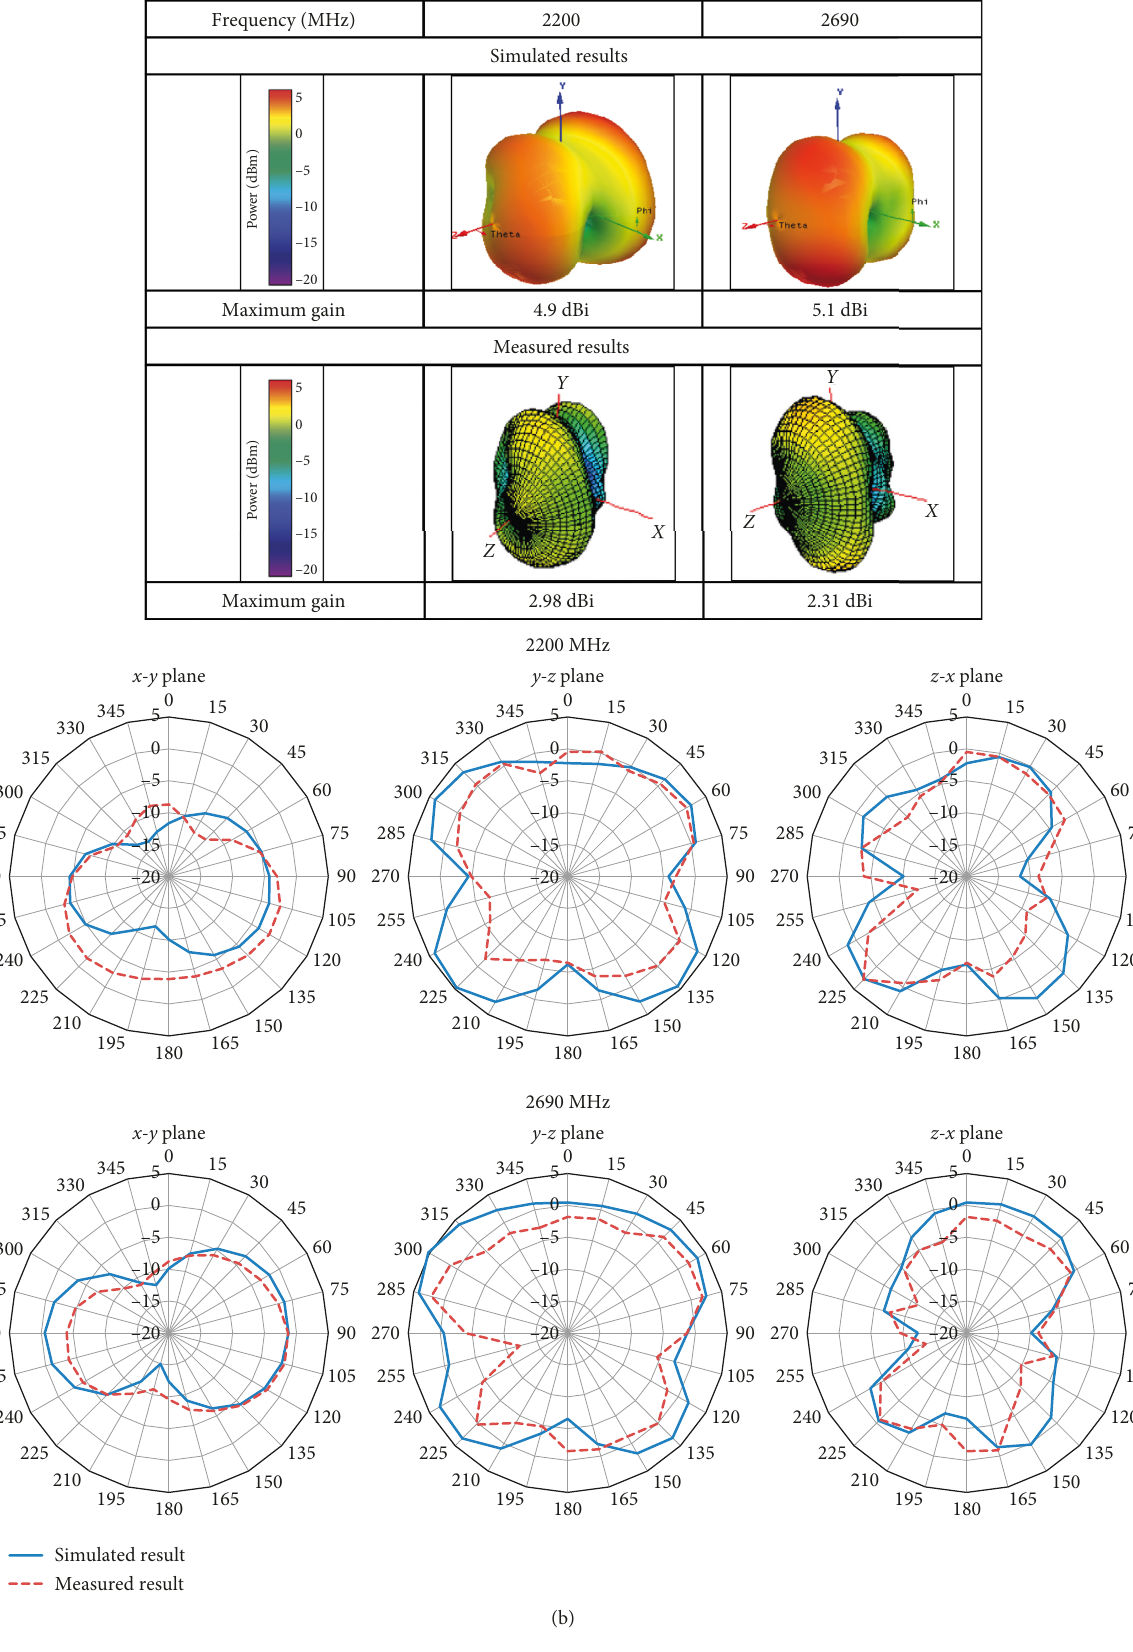
Figure 4: Simulated and measured 2D and 3D radiation patterns of #2. (a) Lower-operating band. (b) Upper-operating